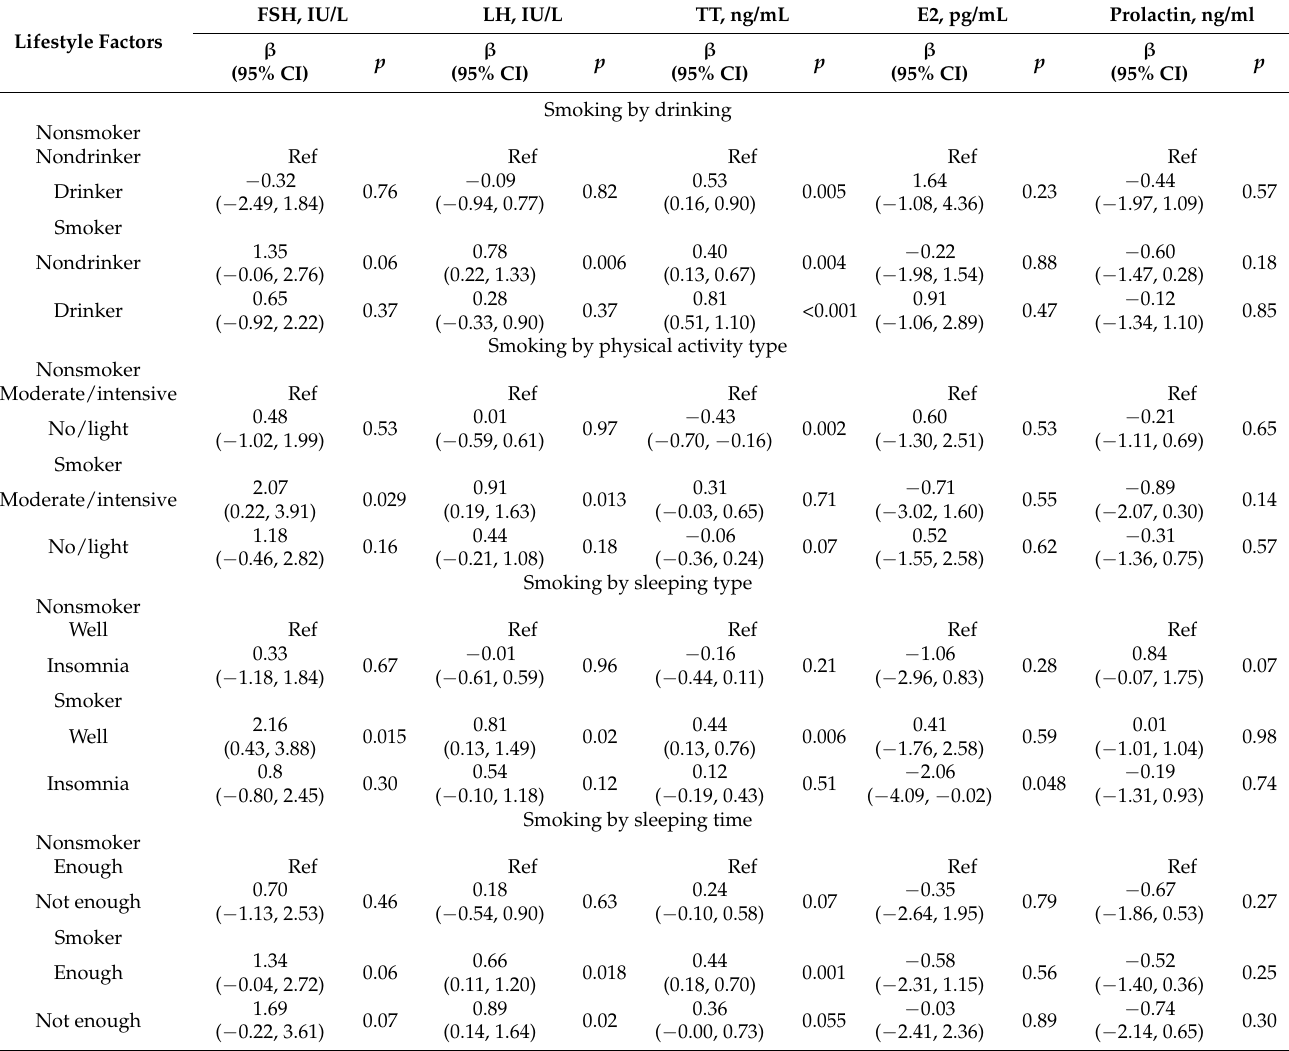
Table 5. Adjusted beta ( β ) coefficient and 95% confidence intervals (CIs) of sex hormones according to interaction of lifestyle